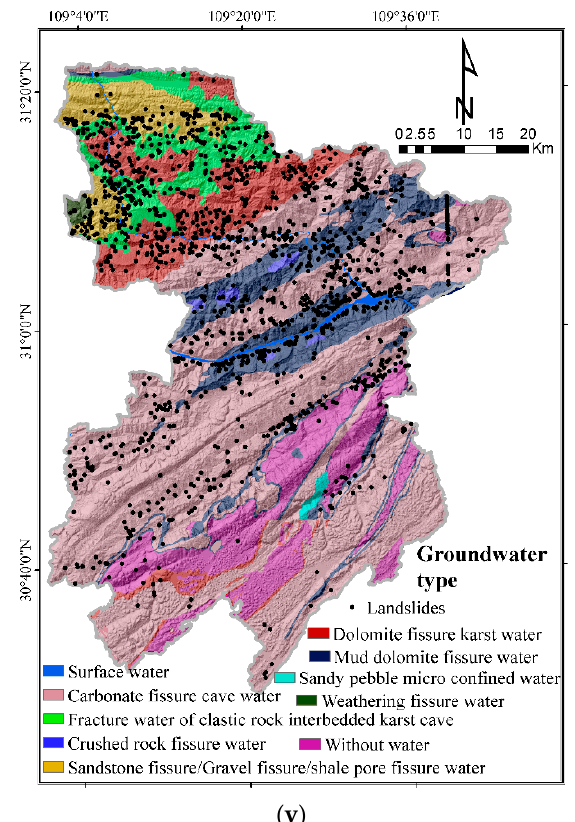
Figure 5. Conditioning Factors on Layer of Landslide Susceptibility: ( a ) Elevation; ( b ) Slope; ( c ) Aspect; ( d ) Curvature; ( e ) Plan curvature; ( f ) Profile curvature; ( g ) Slope shape; ( h ) Slope position; ( i ) Slope variability; ( j ) Micro-landform; ( k ) RDLS; ( l ) TRI; ( m ) Incision density; ( n ) Incision depth; ( o ) TWI; ( p ) Elevation coefficient of variation; ( q ) Lithology; ( r ) Distance from fault; ( s ) CRDS; ( t ) STI; ( u ) Land cover; ( v ) SPI; ( w ) Distance from rivers; ( x ) NDVI; ( y ) Groundwater type